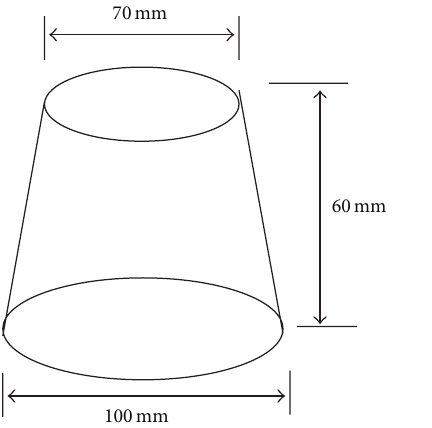
Figure 1: Flow diagram mix for SCC.